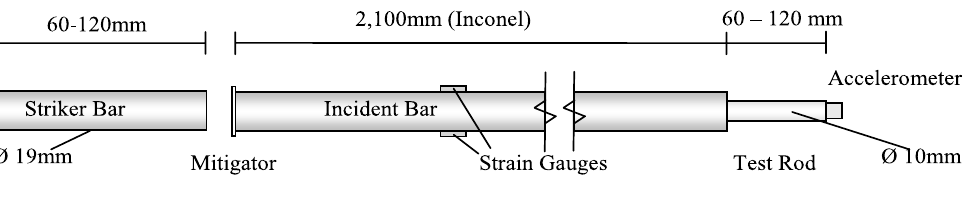
Fig. 2. Hopkinson pressure bar